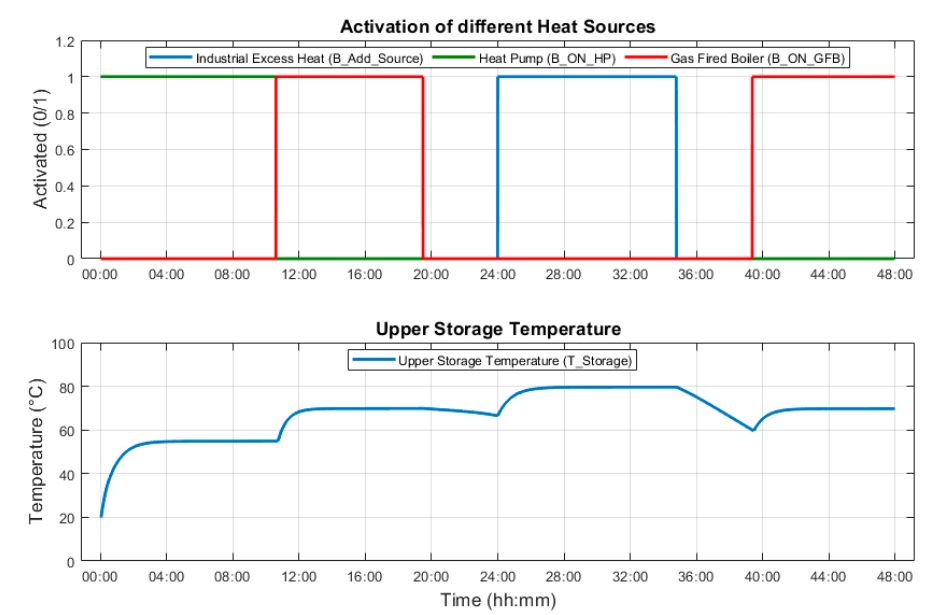
Figure 7. Switching between heat pump, natural gas-fired boiler and industrial excess heat.